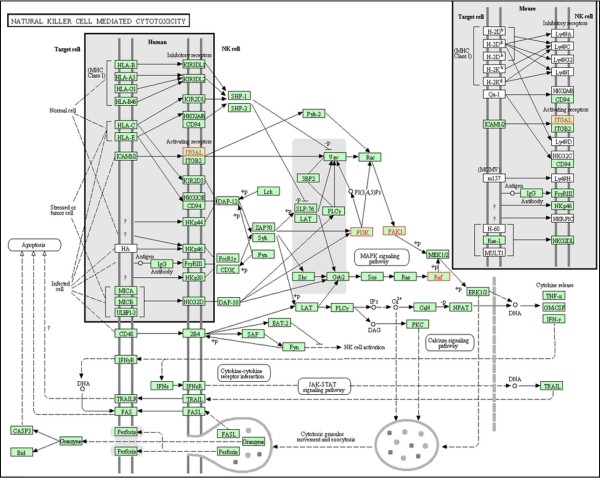
Natural killer cell mediated cytotoxicity pathway figure supplied by KEGG [[34]]. The genes of module 1 reported in this study (see Results section in the main text) are in red.